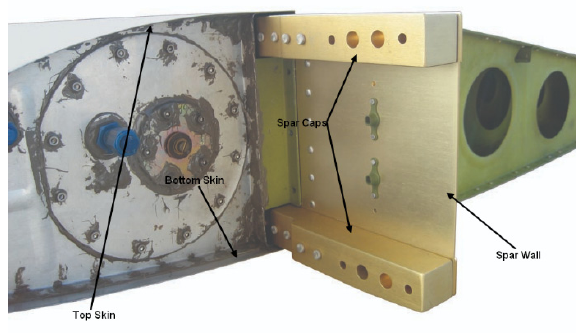
Figure 4. Wing-spar, calculation of torsional constant / per section using formula in Table